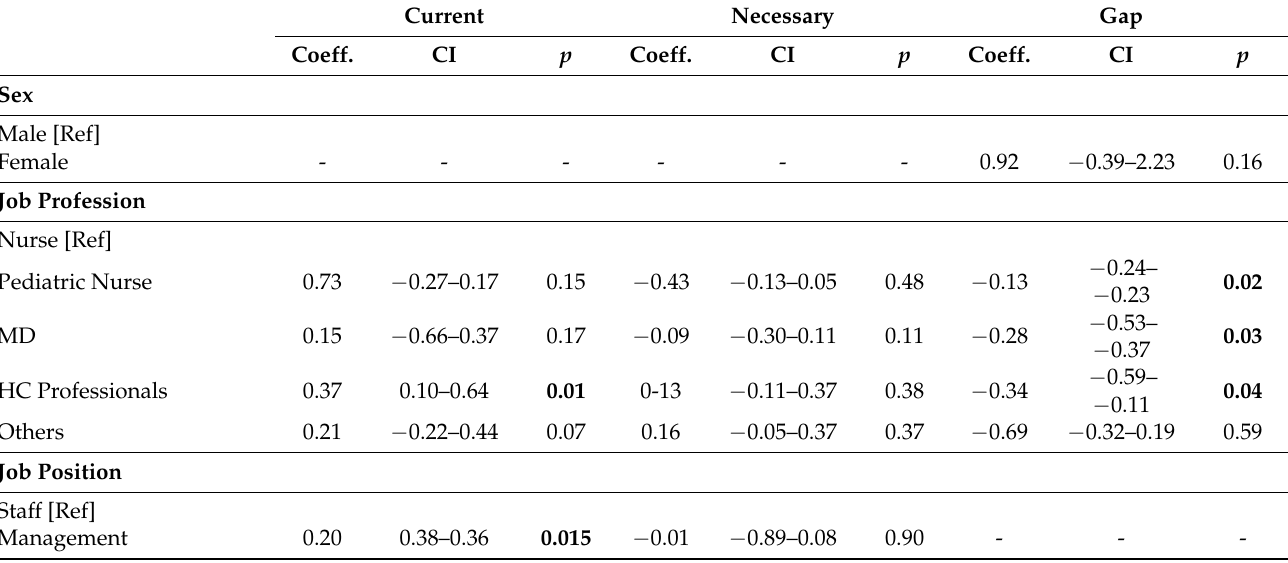
Table 6. Association between Current and Necessary FCCQ-R@it-NICU and Participant Characteris- tics. Results of Multivariate Linear